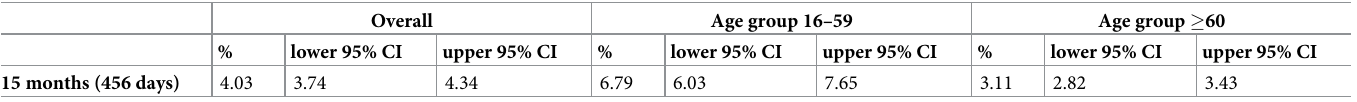
Table 6. % of patients with a sequential vaccination following a first vaccination to a sequential vaccination in a 15-month period in cohort B patients aged 16–59 (upper and lower 95% CI) and � 60 years (upper and lower 95% CI).